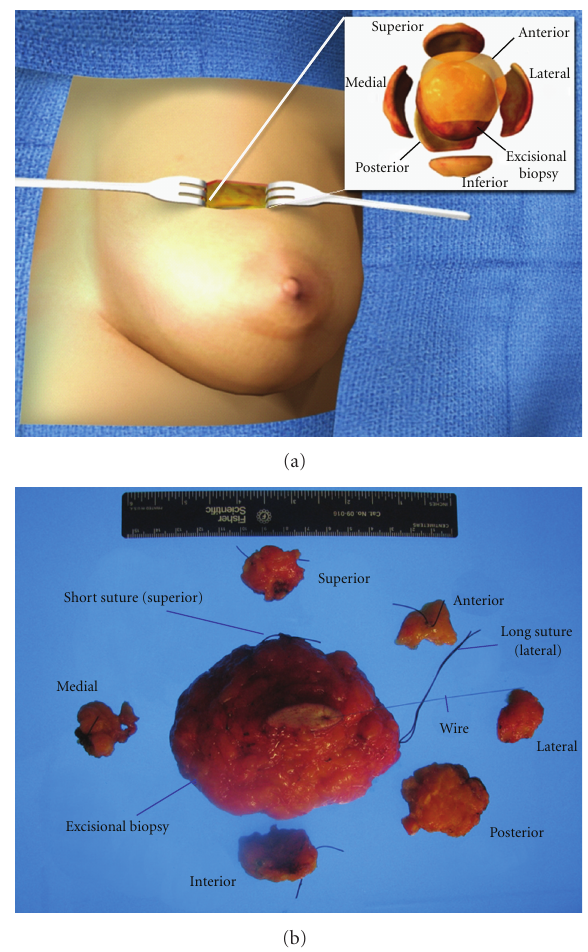
Figure 1: (a) Schematic for BCS-AM. The segmental excision surgical specimen is removed using wire localization. Additional margins can then be re-excised from each of the six faces of the cavity (anterior, posterior, superior, inferior, medial, and lateral). (b) BCS-AM surgical specimen. The total tissue obtained from the BCS-AM procedure includes the original localized lesion (shown with wire placement), as well as one or more additional margins from the six